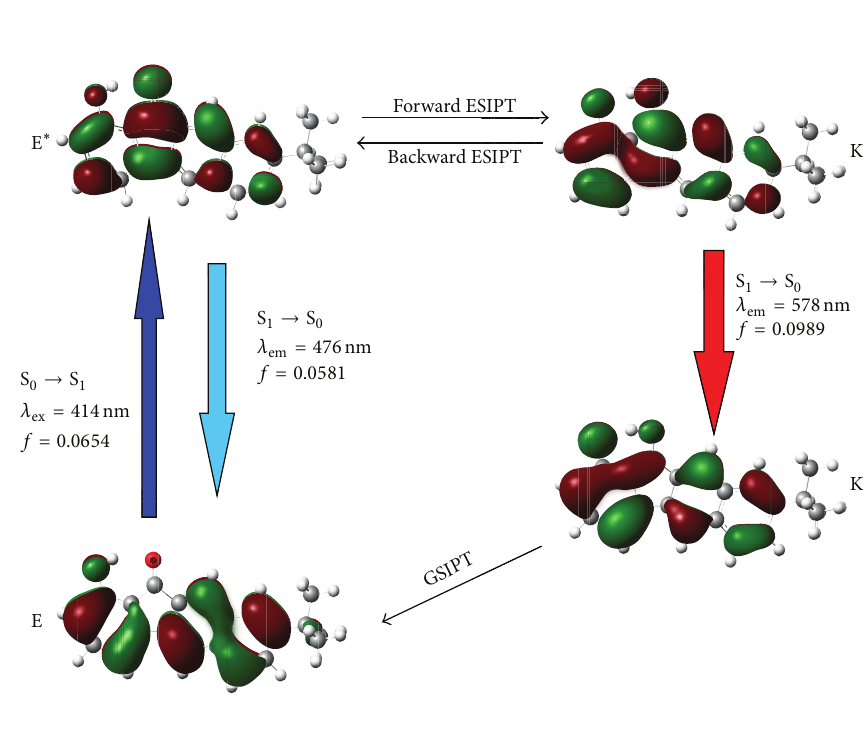
Figure 5: The frontier molecular orbitals of 1 for E, E ∗ , K, and K ∗